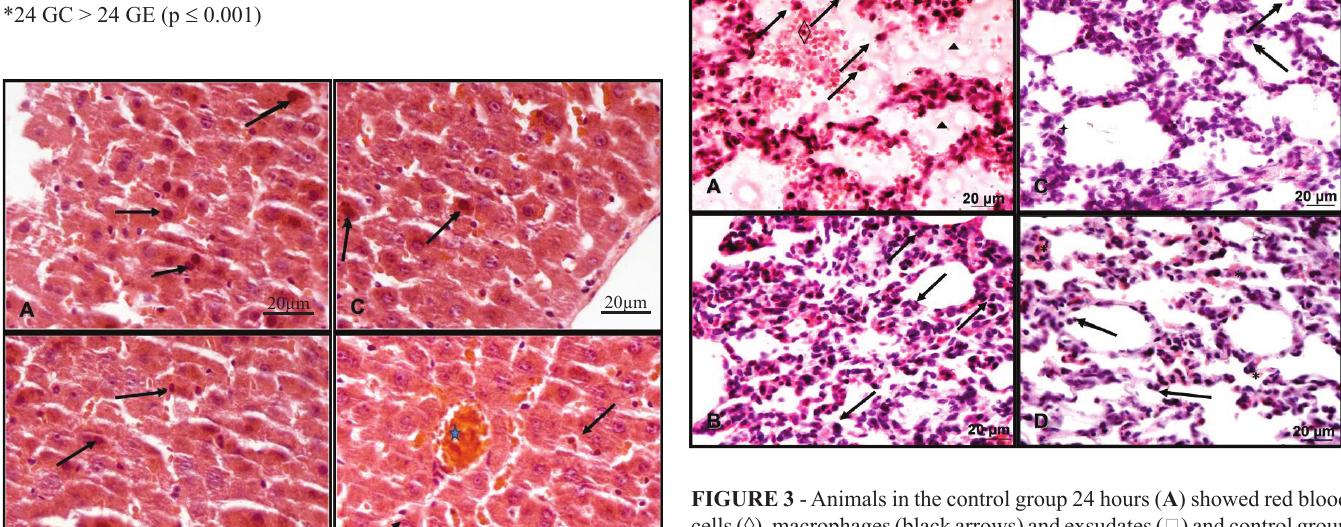
FIGURE 3 - Animals in the control group 24 hours ( A ) showed red blood cells ( ◊ ), macrophages (black arrows) and exsudates (▲) and control group 48 hours ( B ) macrophages (black arrows). Animals Group NAC 24 hours ( C ) show macrophages (black arrows) and leukocytes within the alveolar septa (▲) and animals of Group NAC 48 hours ( D ) alveoli with thickened walls and less congested with macrophages (black arrows). (HE-400